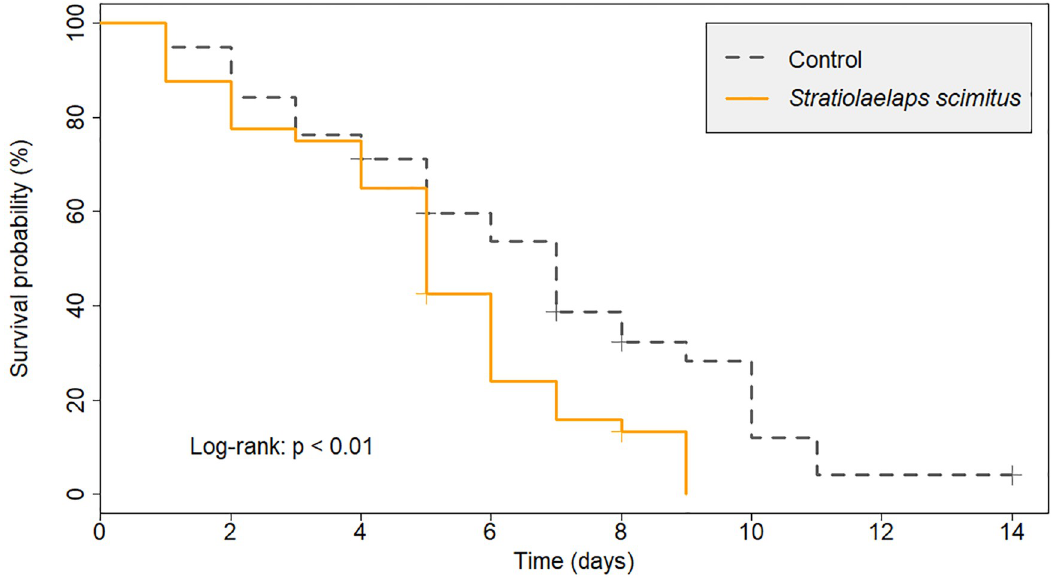
Fig 5. Kaplan-Meier survival curves of the phoretic Varroa mites when confined in experimental arenas with 20 starved Stratiolaelaps scimitus individuals (n = 40) or none (control; n = 38). Each arena consisted of a modified plastic pill bottle and contained one worker bee parasitized by a single Varroa mite. Death events of both the Varroa and the bee have been recorded once a day and Varroa death events that occurred on the same day as their respective bee death were considered as right censored data.